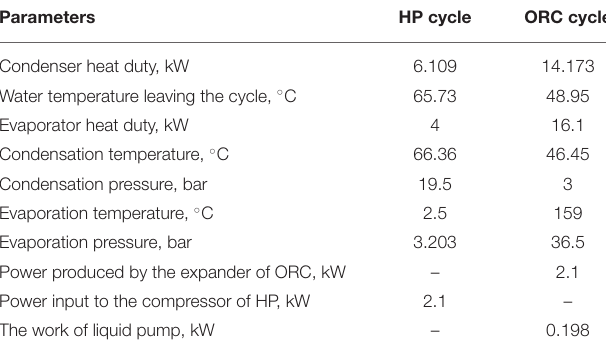
TABLE 3 | Steady state result for the second approach.